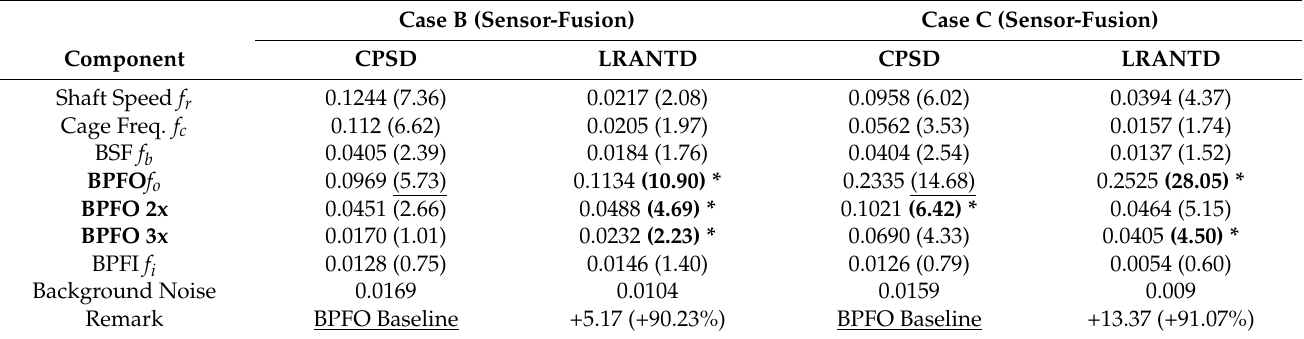
Table 4. Characteristic spectral amplitude in g (with its ratio to the mean background noise) for Case B and Case